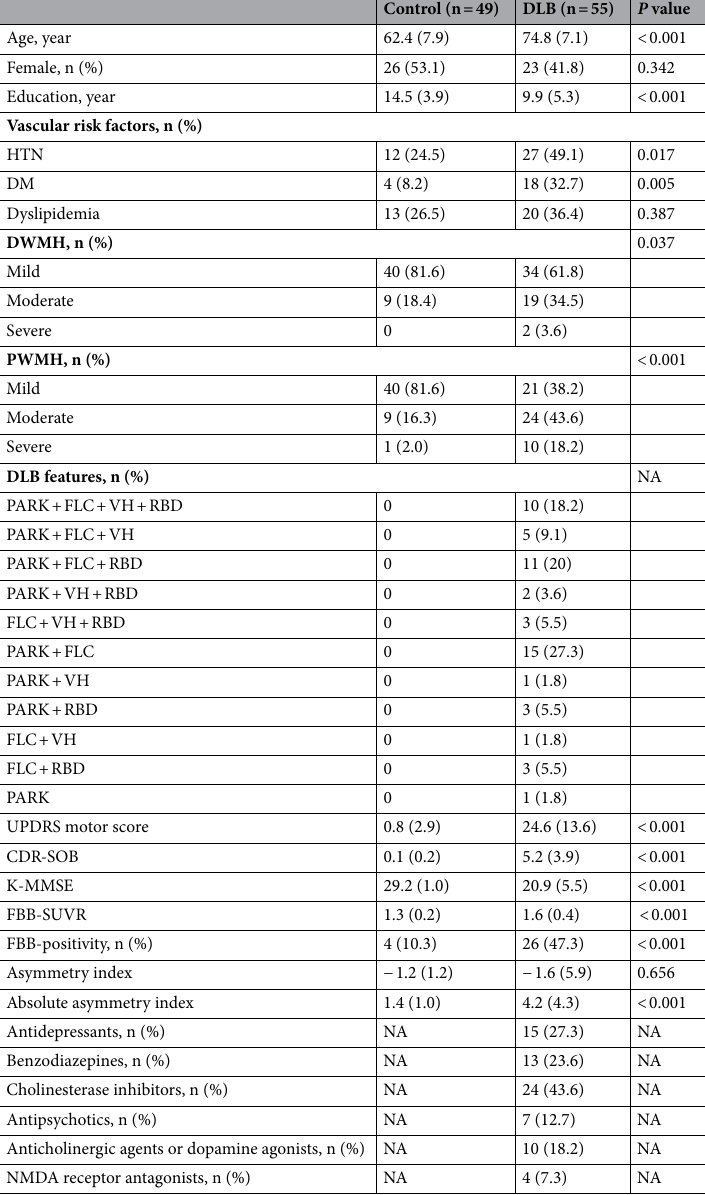
Table 1. Demographic and clinical characteristics of study participants. Data are expressed in mean (SD) or number (%). Group comparisons were performed using independent t tests or Chi-square tests. CDR-SOB clinical dementia rating sum of boxes, DLB dementia with Lewy bodies, DM diabetes mellitus, DWMH deep white matter hyperintensities, FBB-SUVR 18 F-Florbetaben standardized uptake value ratio, FLC fluctuation, HTN hypertension, K-MMSE Korean version of the Mini-Mental State Examination, NA not applicable, NMDA N-methyl-d-aspartate, PARK parkinsonism, PWMH periventricular WMH, RBD rapid eye movement sleep behavior disorder, UPDRS unified Parkinson’s disease rating scale, VH visual